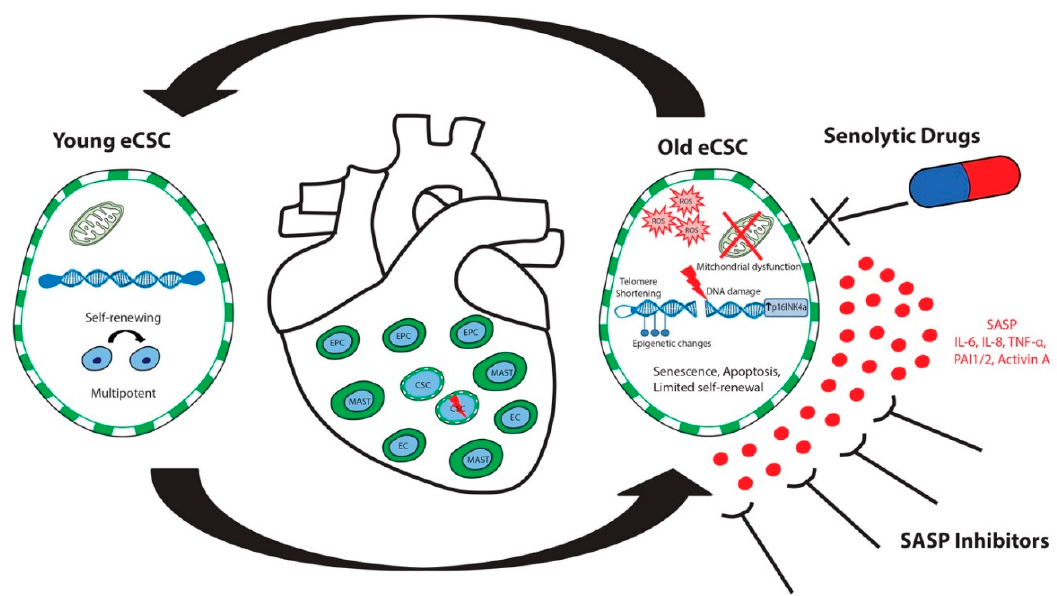
Figure 3. Molecular and Cellular Mechanisms of Senescence: Replicative senescence and SASP characterize the senescent phenotype of aged and dysfunctional CSCs. Senolityc drugs and SASP inhibitors are able to eliminate senescent cells and senescent dysfunctional CSCs, thus favoring the expansion of healthy and functional